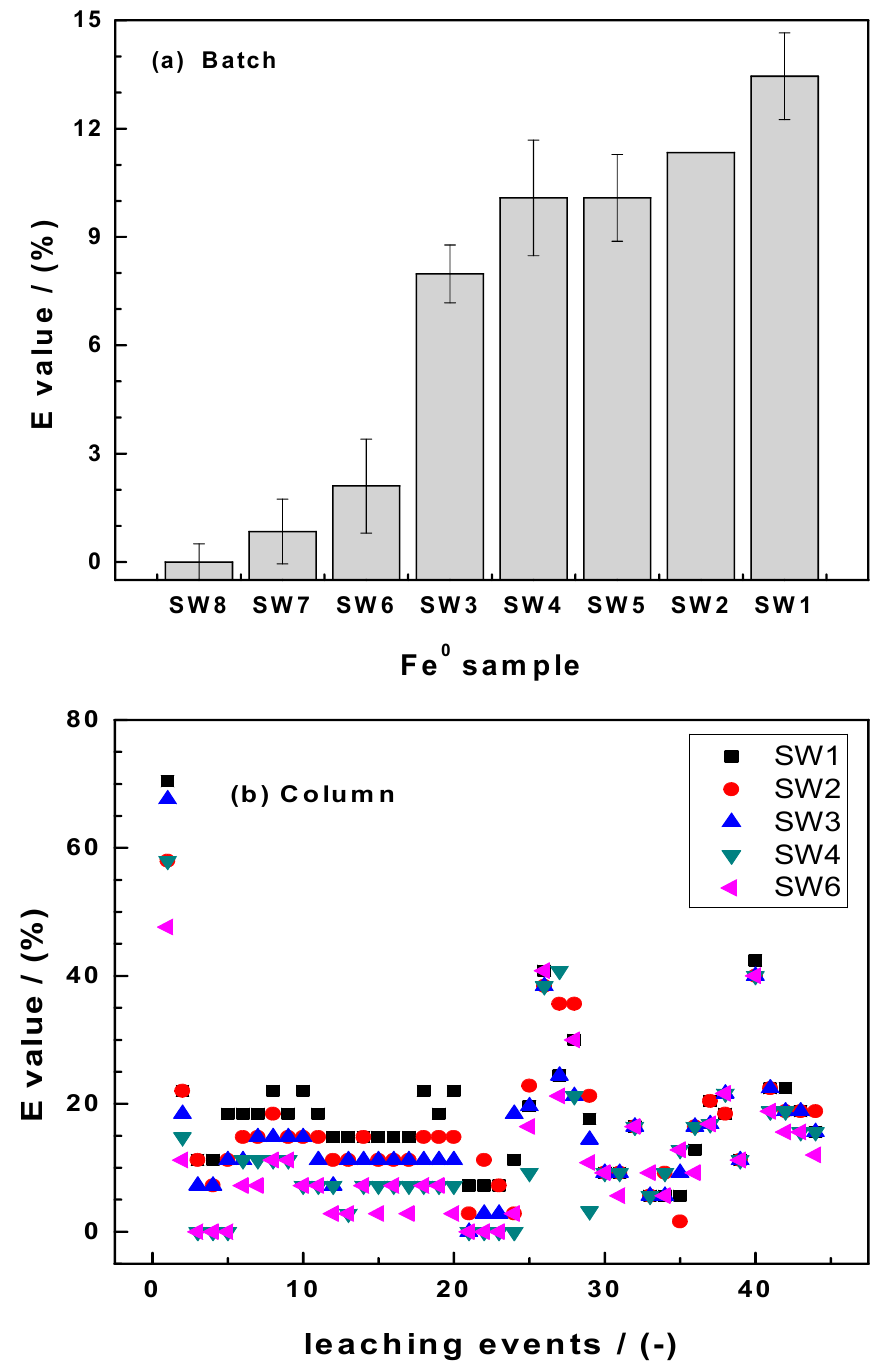
Figure 6. Extent of water defluoridation in ( a ) batch experiments and ( b ) intermittent column filtration. Experimental column conditions: 2.0 g Fe 0 SW; V = 22 mL; [F − ] = 25 mg/L.